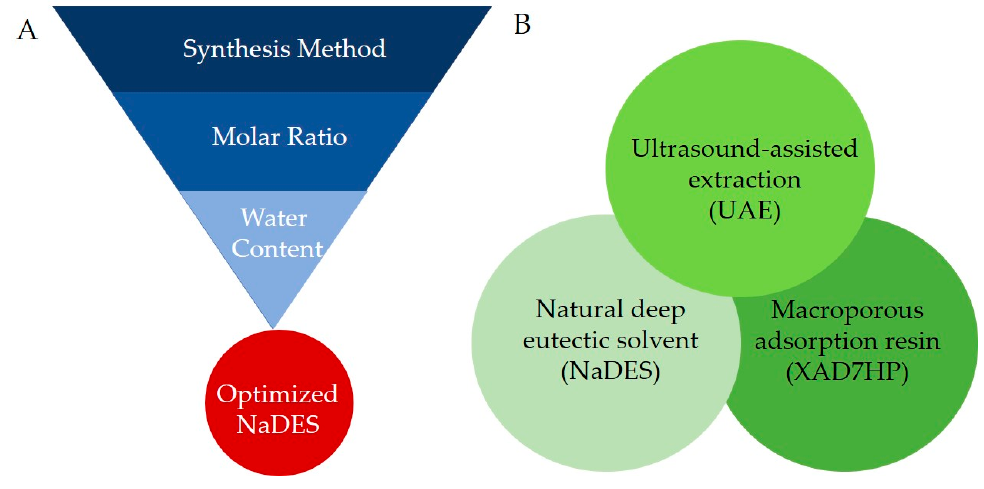
Figure 1. Structures of hydrogen bond acceptor (HBA) and hydrogen bond donor (HBD) used in the present study.